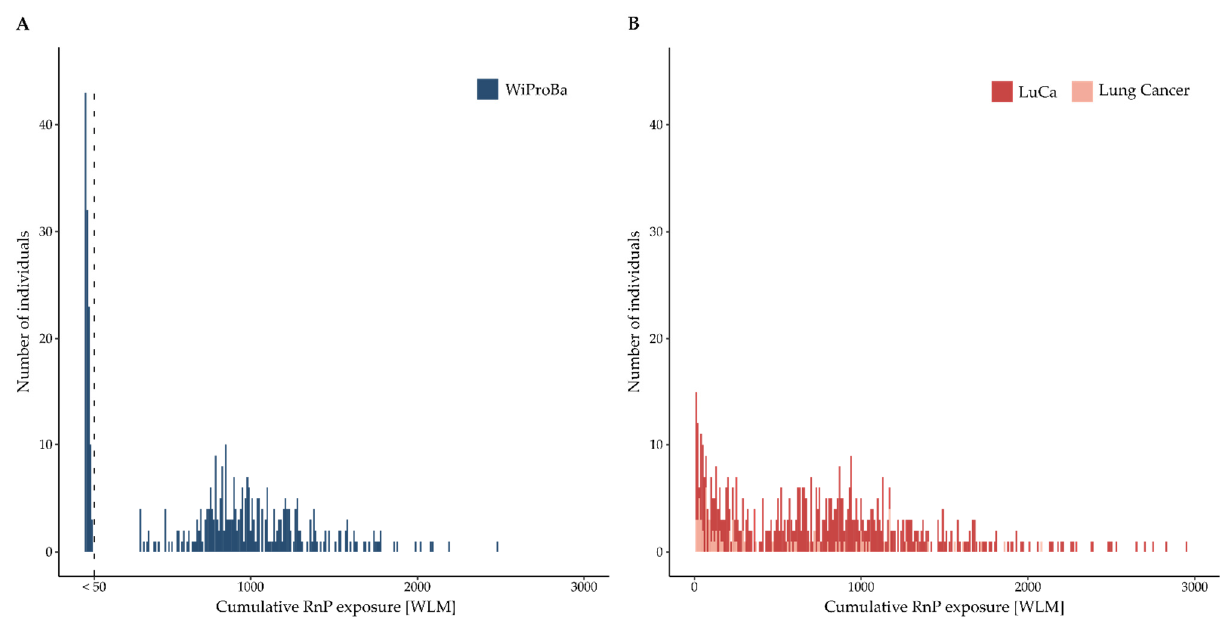
Figure 4. Cumulative radon and radon progeny (RnP) exposure of individuals in the WiProBa ( A ), LuCa and lung cancer ( B ) subgroups. The dotted line (in Figure 4A) marks a WLM exposure of 50. In addition to the moderately and highly exposed miners (>50 WLM), a control group of less exposed ( ≤ 50 WLM) miners were recruited and matched according to age and smoking.